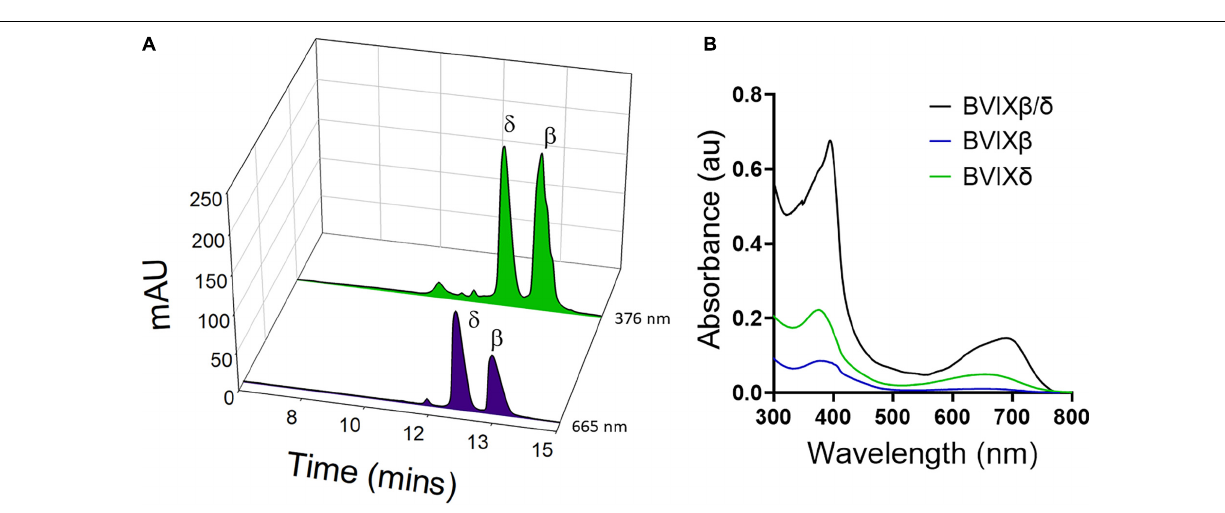
FIGURE 3 | HPLC separation of BVIX δ , and - β isomers from supernatant. (A) HPLC separation of extracted BVIX δ and - β isomers using a linear gradient of solvent A, ACN:0.1% formic acid and B, H 2 O:0.1% formic acid over 30 min with retention times 12.1 min and 13.0 min, respectively. (B) UV-vis spectrum of C18 purified BVIX β / δ (peaks at 394 and 680 nm) and HPLC purified BVIX β (peaks at 378 and 650 nm), and - δ isomers (peaks at 376 and 650 nm) in 100%